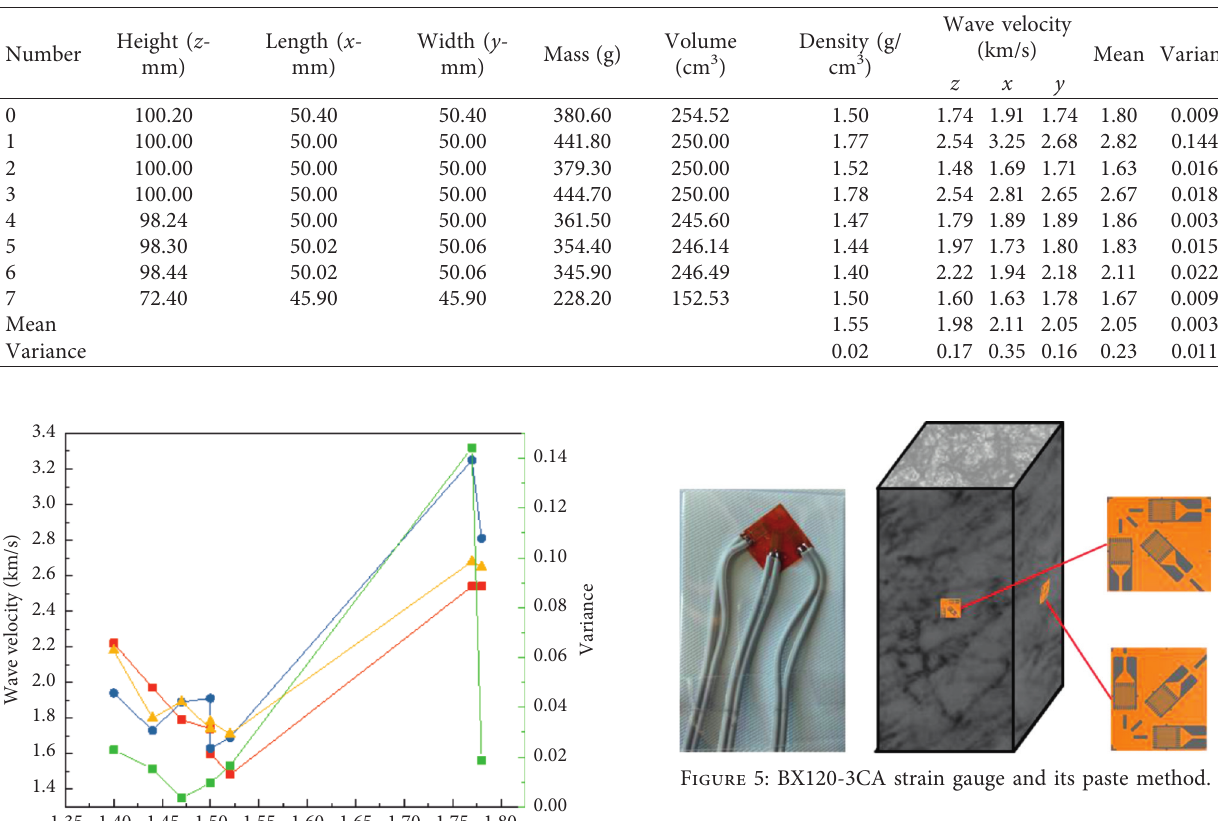
Table 1: Preliminary parameters of coal samples.